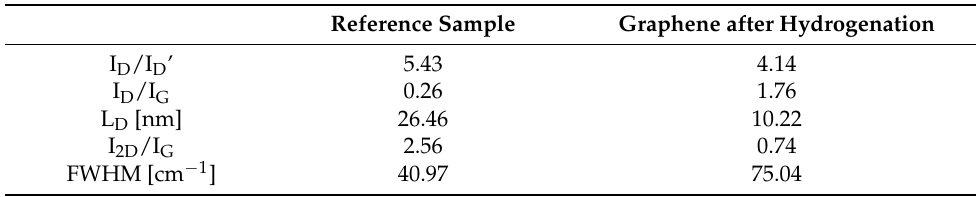
Figure 2. Raman spectra for unmodified graphene (A) and graphene subjected to plasma hydrogenation (B). Table 1. The ratios of the intensity of the characteristic peaks and the FWHM value calculated from the deconvolution of the Raman